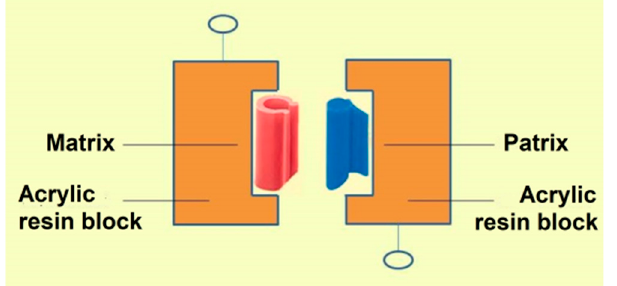
Figure 1. Test arrangement.